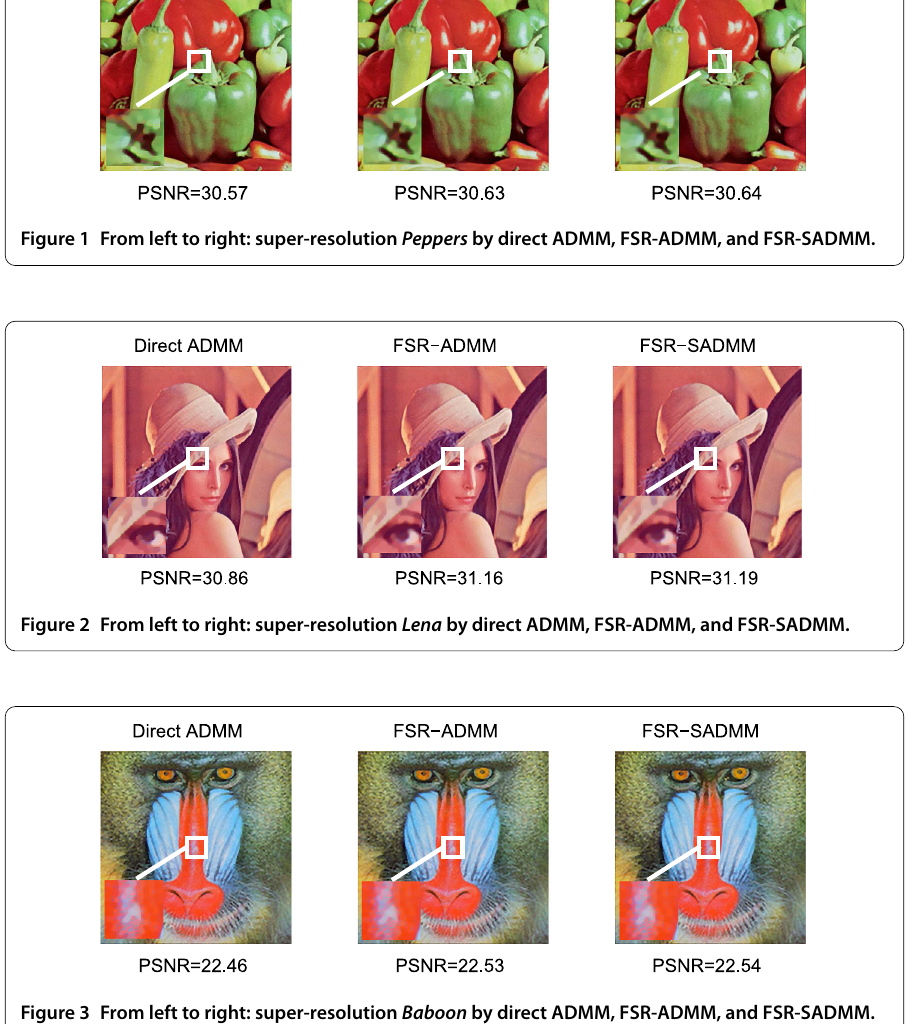
of the Peppers, the wrinkles on the eyes of Lena, and also hair on Boboon’s nose.